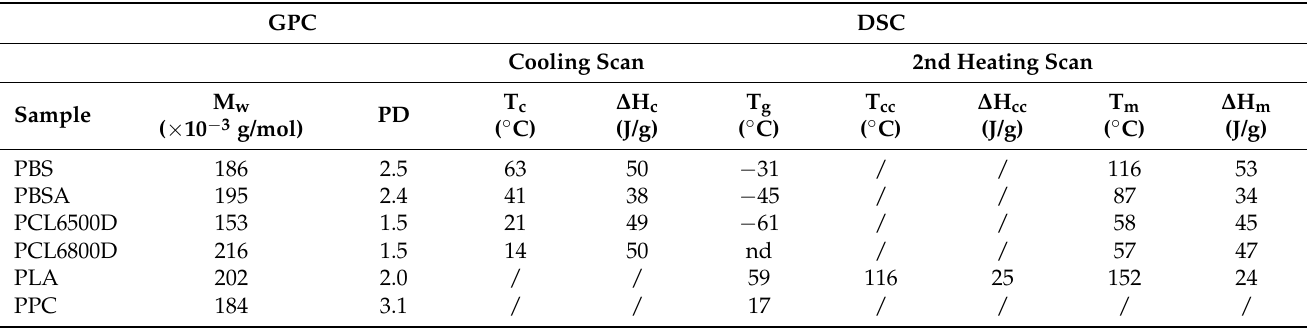
Table 2. Molecular and thermal properties of polyester pellets as